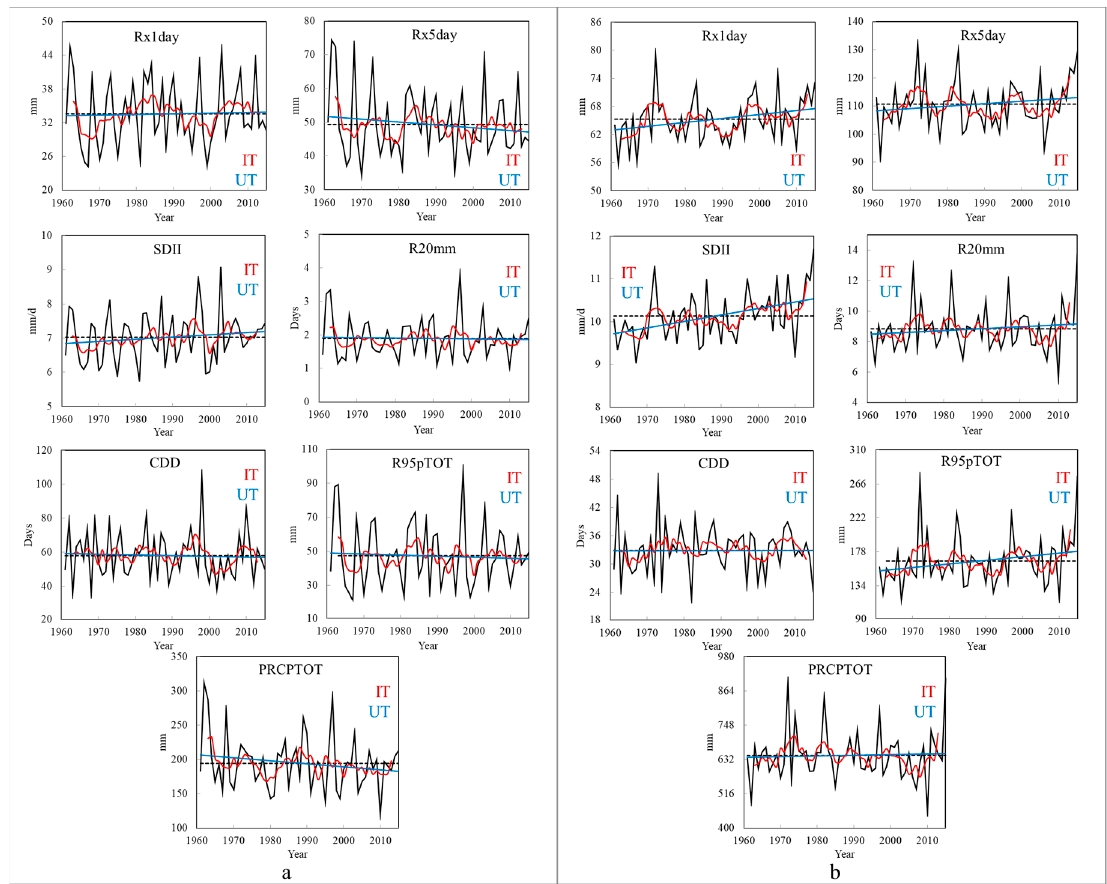
Figure 14. Annual variations of the spatially averaged extreme precipitation indices and the trend strengths and trend stability test results during the growth period of October 1961 to May 2016. The black curves show the arithmetic average values of the total meteorological stations. The red curves give the five-year moving average. The black horizontal dotted lines represent the average level, and the blue lines show the trends. The northern China winter wheat region is denoted by ( a ). The southern China winter wheat region is denoted by ( b ). The trend strength is expressed in red letters. The stability of the trend is expressed in blue letters. IT represents insignificant trends. UT represents unstable trends.